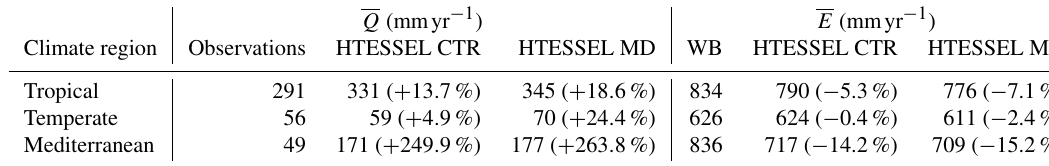
Table 2. Long-term annual mean modeled discharge ( Q ) and evaporation ( E ) in the HTESSEL CTR and MD versions for the tropical, temperate and Mediterranean climate regions (catchment averages) as well as reference Q (station observations) and E ( E WB , Sect. 2.2). The p biases of the modeled climate region average Q and E are presented between brackets. Similar values for the individual catchments are shown in Tables S3 and S4.